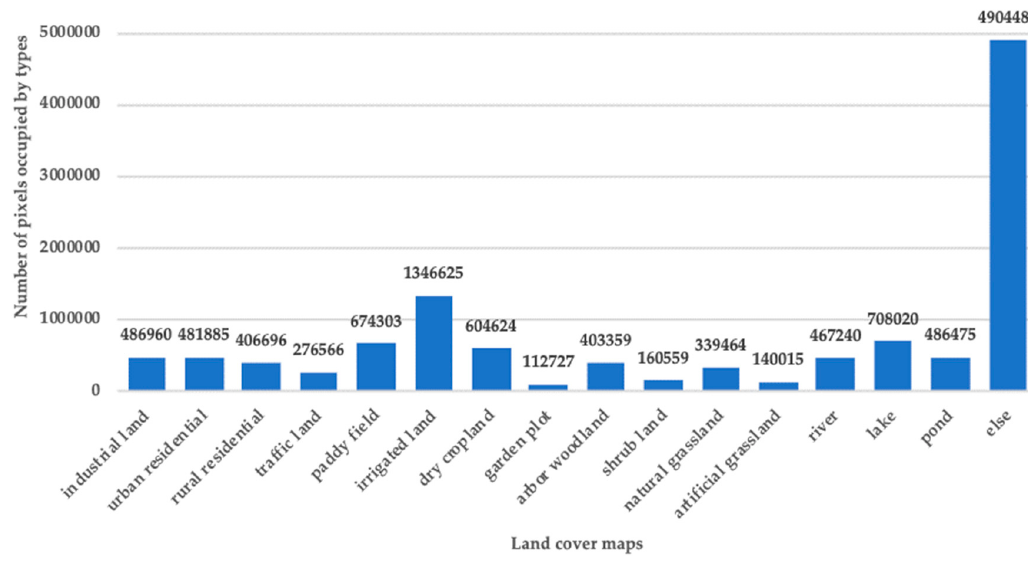
Figure 4. Gaofen Image Dataset (GID) distribution.